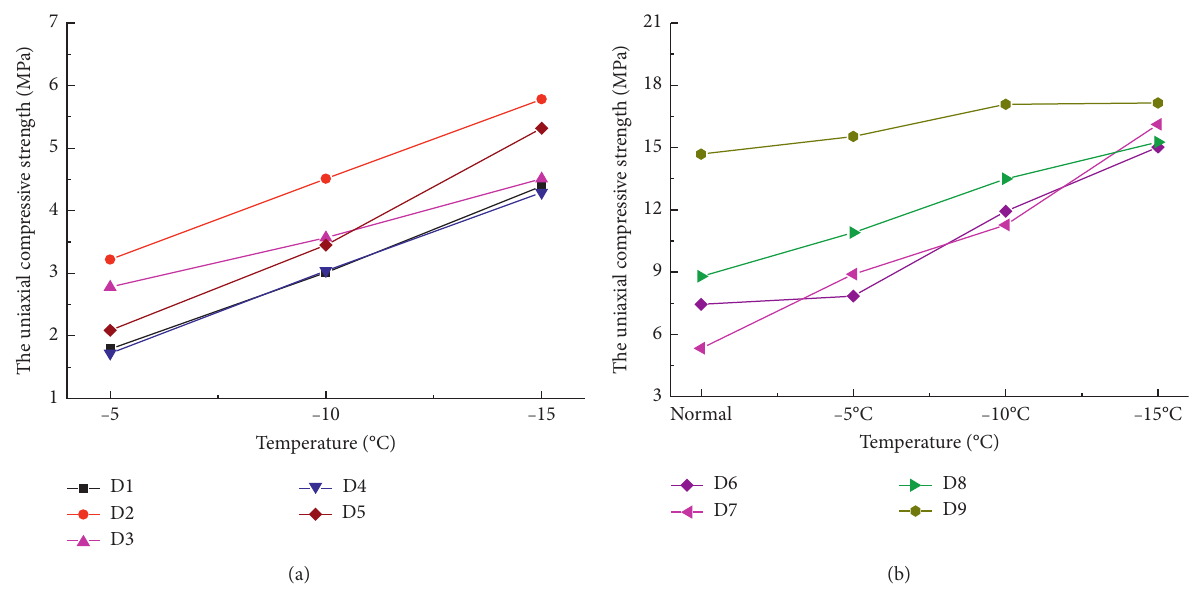
Figure 1: Uniaxial compressive strengths of different rock and soil strata versus temperature. (a) Topsoil strata. (b) Rock strata.